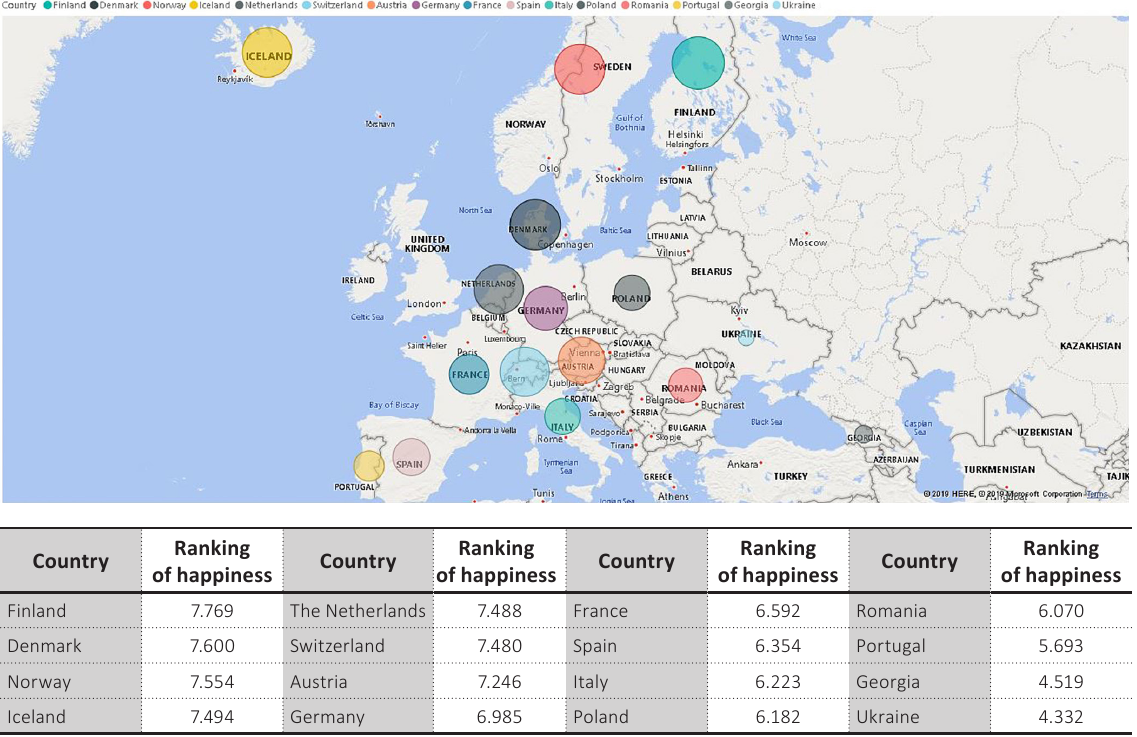
Figure 2. Visualization of the values of the ranking of happiness among some European